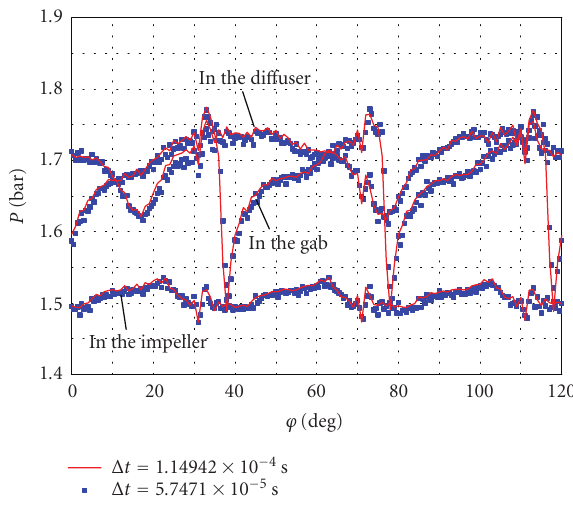
Figure 17: Time-step e ff ects on unsteady